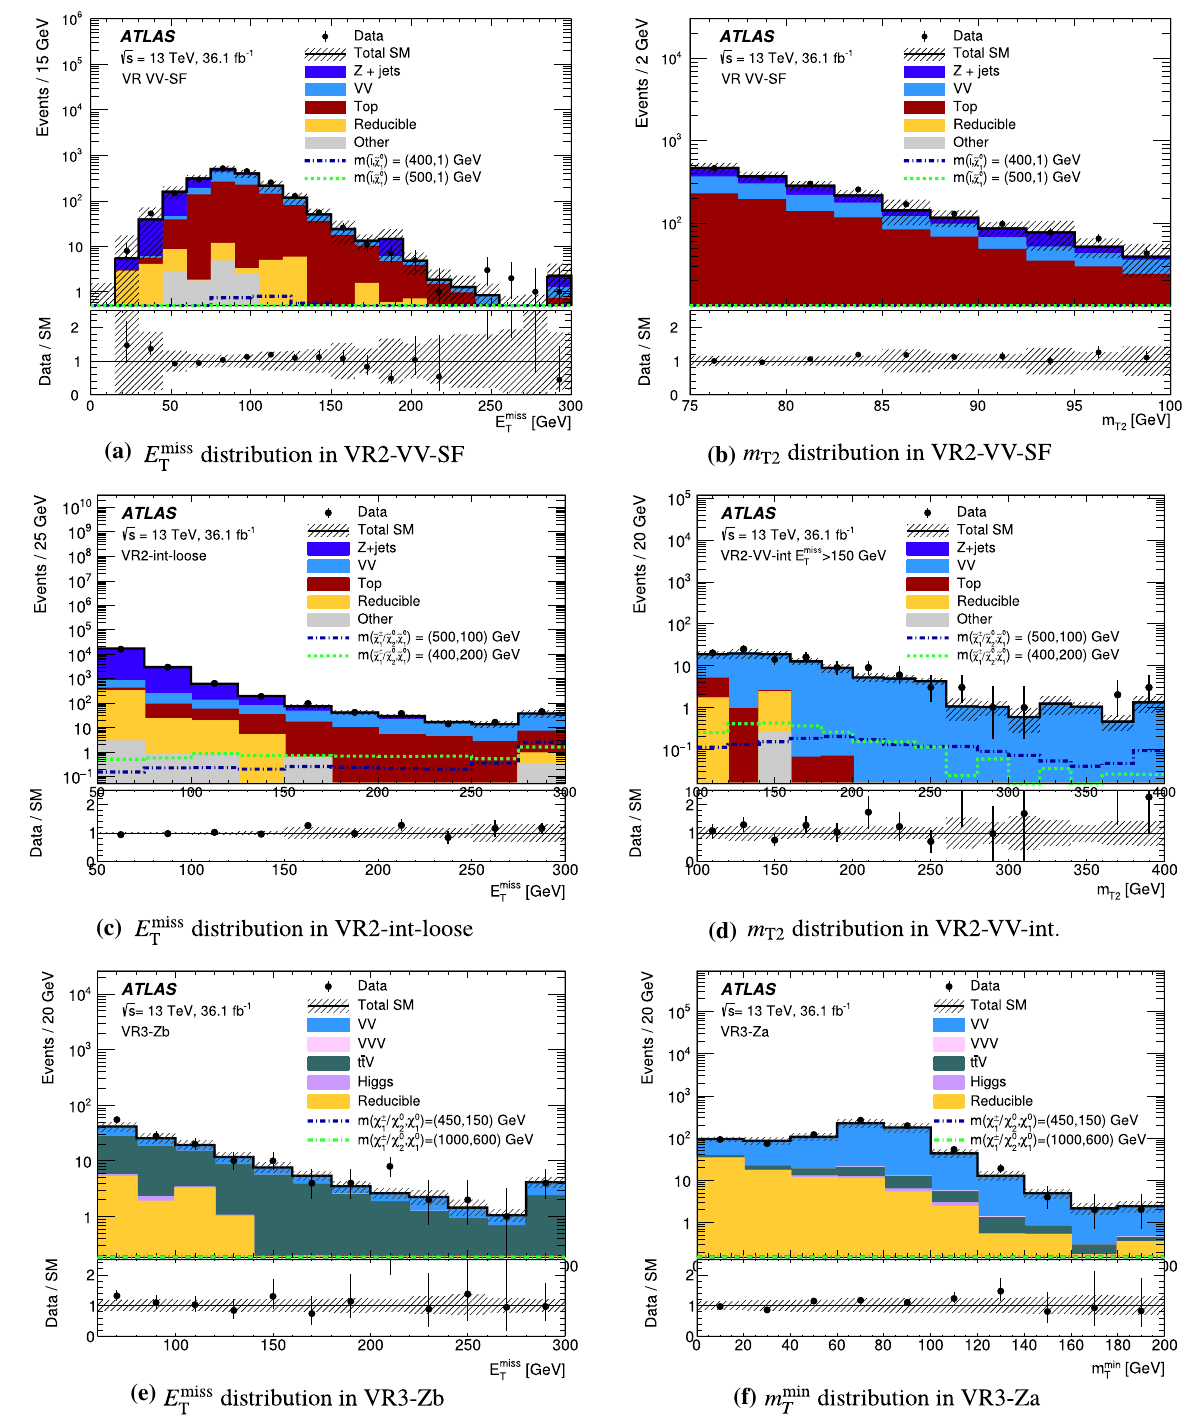
Fig. 2 Distributions of E miss the “top” background includes t ¯ t , Wt and t ¯ tV , the “other” backgrounds , m min , and m T2 for data and the esti- T T include Higgs bosons and V V V , the “reducible” category corresponds mated SM backgrounds in the (top) 2 (cid:4) + 0 jets channel, (middle) 2 (cid:4) to the data-driven matrix method estimate, and the Z + jets contribu- + jets channel, and (bottom) 3 (cid:4) channel. Simulated signal models are tion is evaluated with the data-driven γ + jet template method. For overlaid for comparison. For the 2 (cid:4) + 0 jets (3 (cid:4) ) channel, the normaliza- the 3 (cid:4) channel, the “reducible” category corresponds to the data-driven tion factors extracted from the corresponding CRs are used to rescale fake-factor estimate. The uncertainty band includes all systematic and the t ¯ t and V V ( W Z ) backgrounds. For the 2 (cid:4) + 0 jets channel the statistical sources and the final bin in each histogram also contains the “top” background includes t ¯ t and Wt , the “other” backgrounds include events in the overflow Higgs bosons, t ¯ tV and V V V and the “reducible” category corresponds to the data-driven matrix method estimate. For the 2 (cid:4) + jets channel,